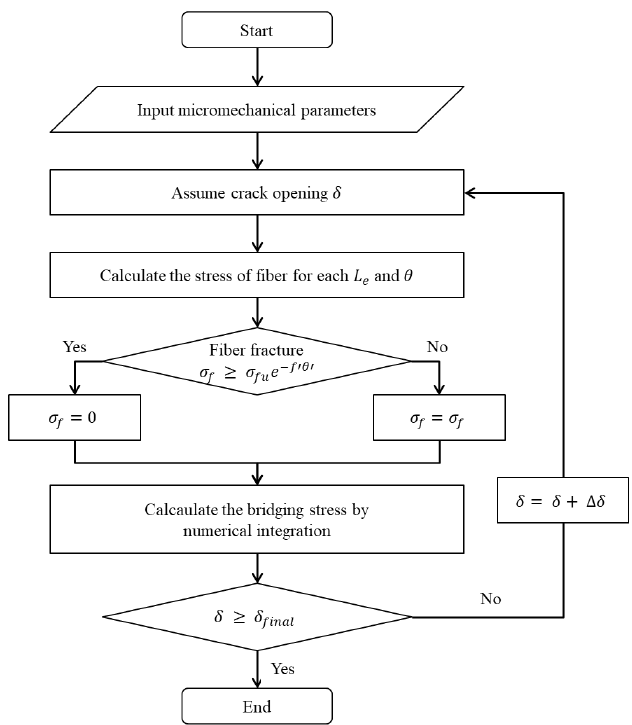
Figure 8. Numerical procedure for obtaining fiber-bridging curve.